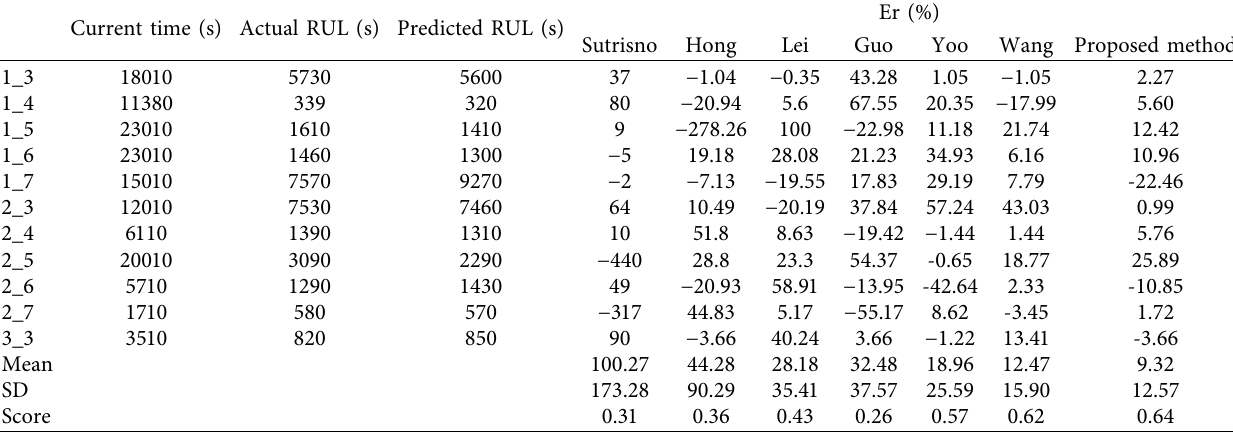
Table 5: The RUL prediction results of different